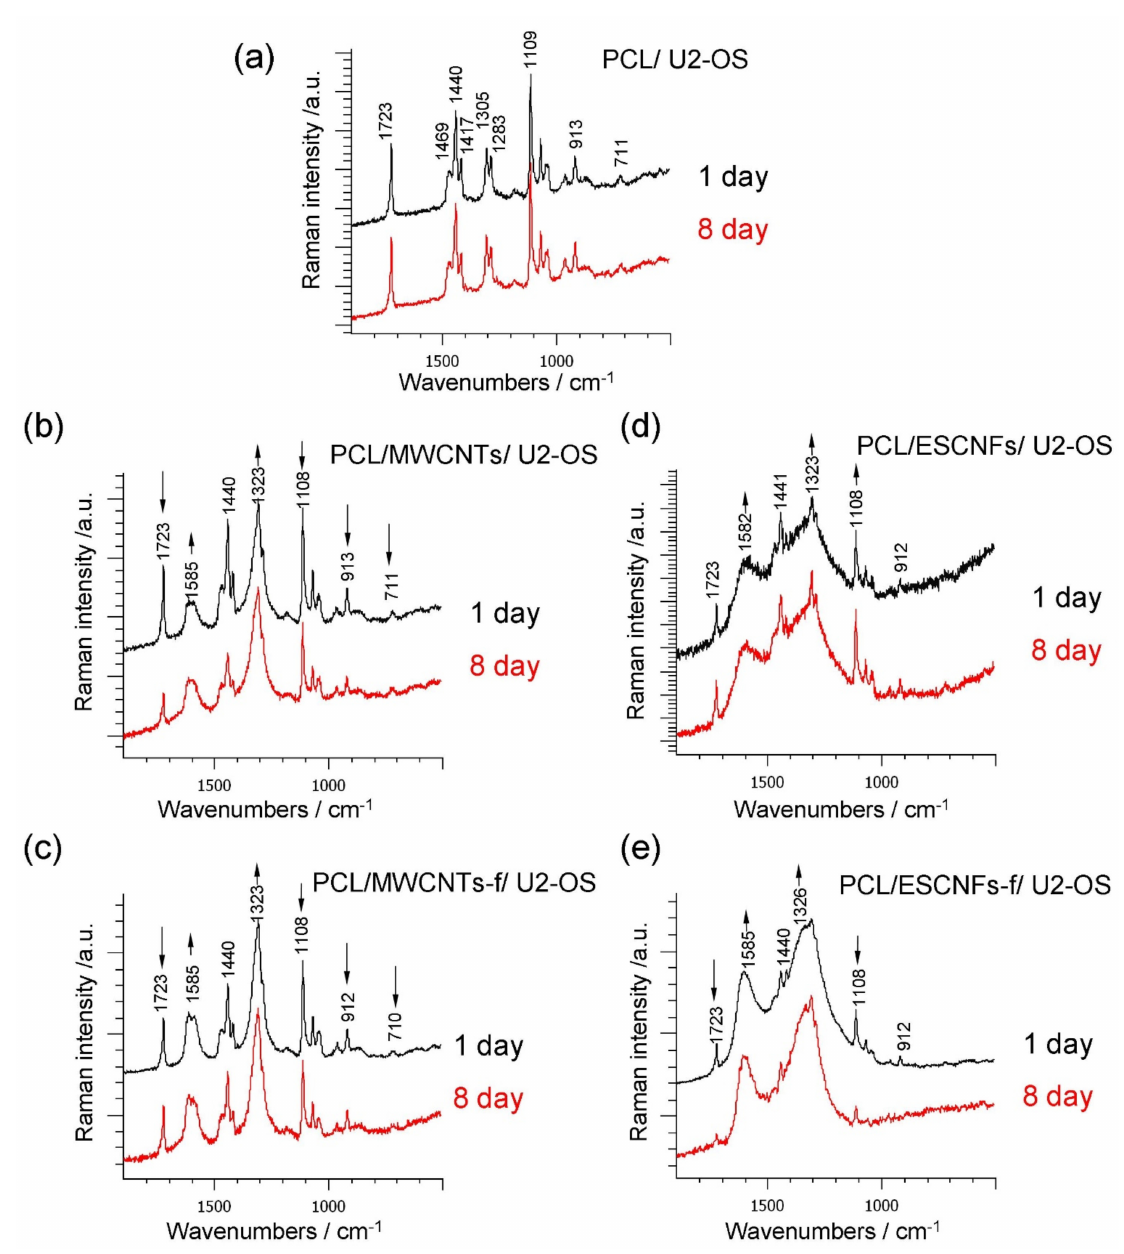
Figure 5. Raman spectra of the U-2 OS cell culture on the substrate: ( a ) PCL; ( b ) PCL/MWCNTs; ( c ) PCL/MWCNTs-f; ( d ) PCL/ESCNFs and ( e ) PCL/ESCNFs-f, on day 1st and 8th; 1900–500 cm − 1 range, 785 nm excitation